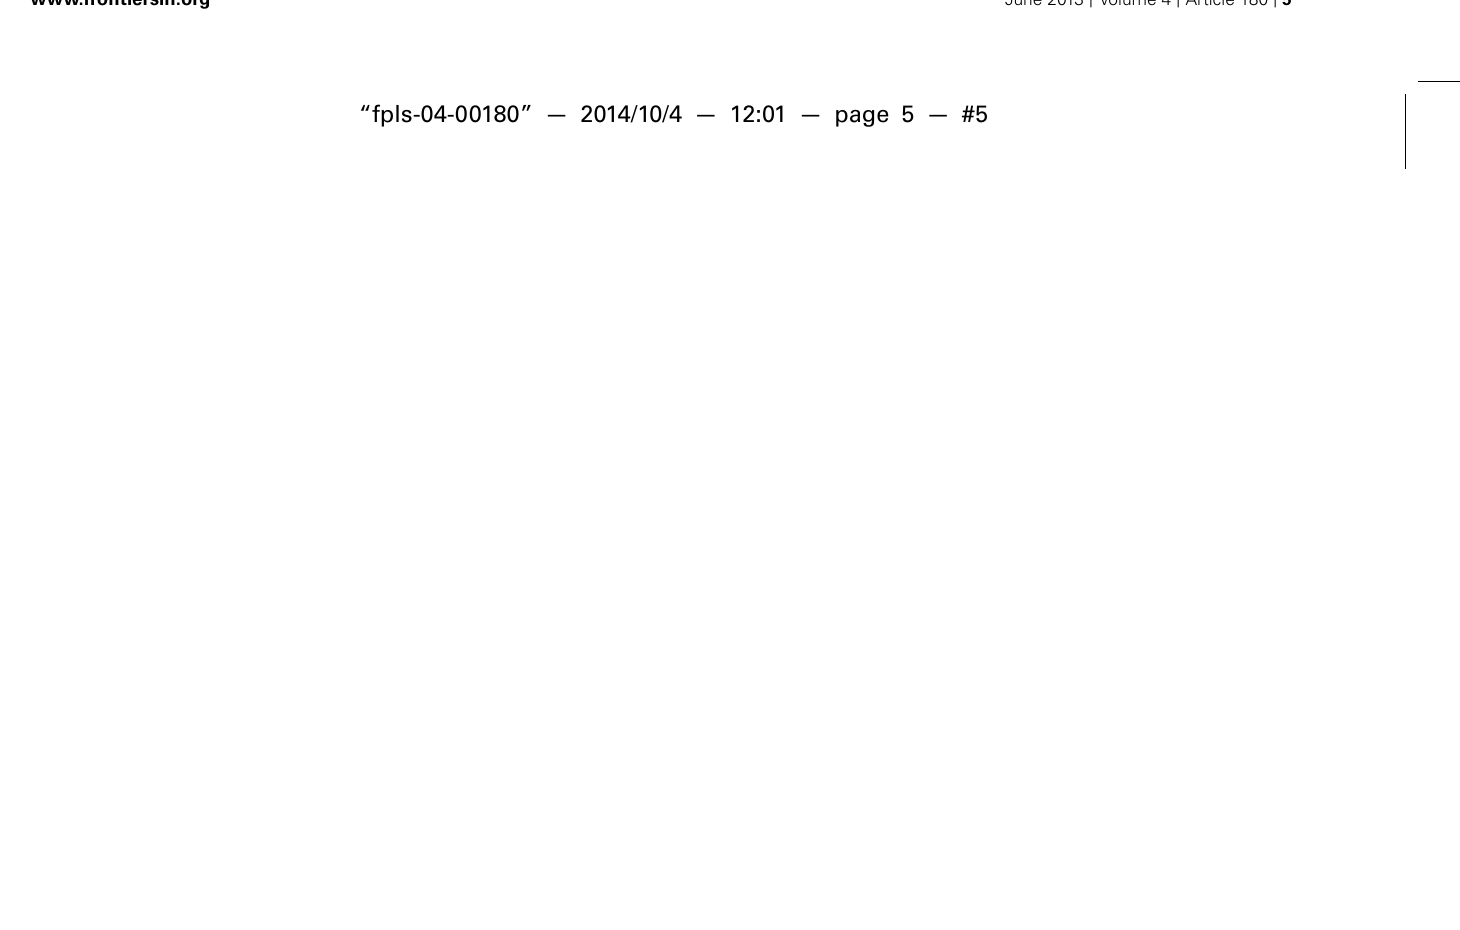
solution, containing 2 μ M Zn, and supplemented to 100, 1000, or 3000 μ M Zn, respectively 10, 50, or 100 μ M Cd for G. claussenii and 100 or 1000 μ M of Zn, respectively 5 or 50 μ M of Cd for G. elegans